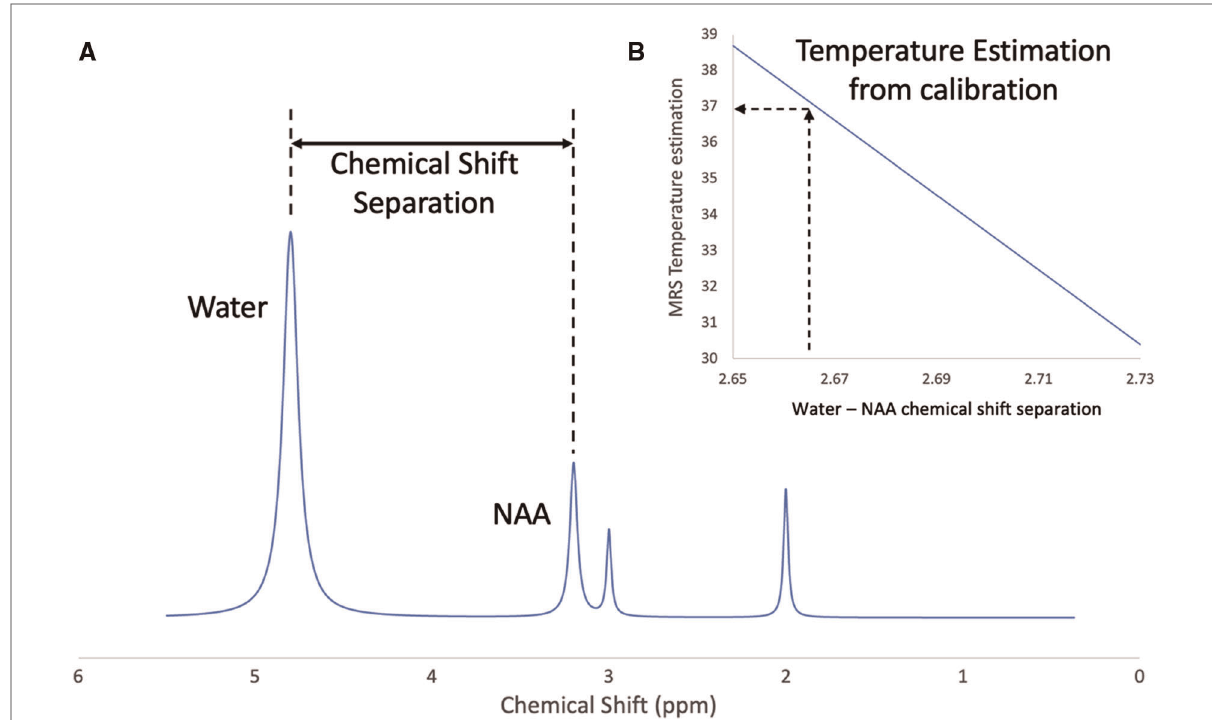
FIGURE 1 Brain temperature measurement using proton magnetic resonance spectroscopy. ( A ) Indicates the chemical shift separation between the water peak and a reference metabolite (NAA), ( B ) represents the calculation of brain temperature using a calibration based on the water-NAA chemical shift